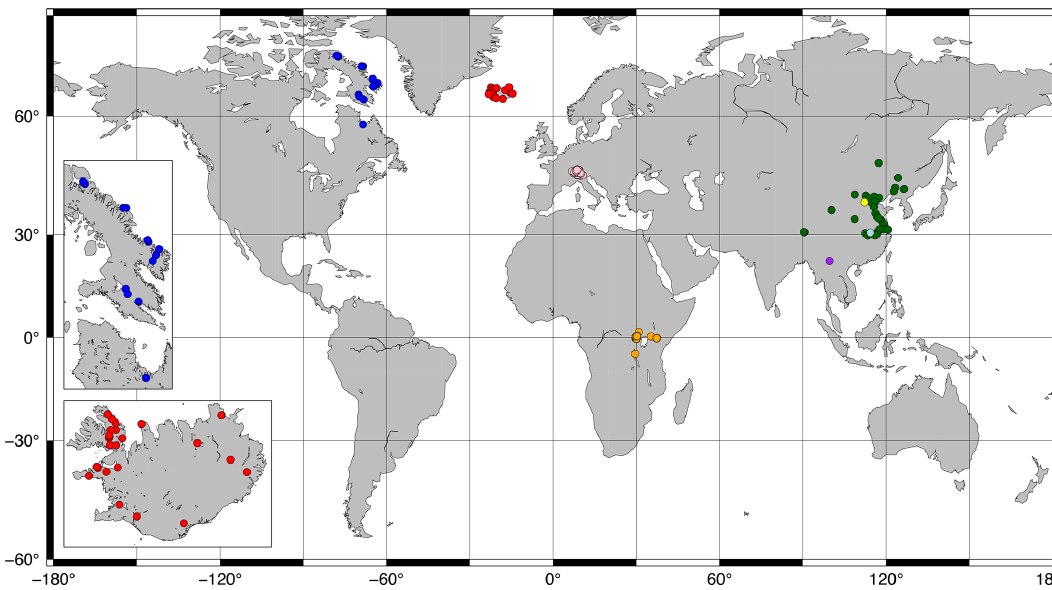
Figure 1. Map of sites included in this study. Red and blue: Iceland and Canada (this study; see insets); orange: Russell et al. (2018); green: Dang et al. (2018); pink: Weber et al. (2018); yellow: Cao et al. (2020); light blue: Qian et al. (2019); purple: Ning et al.